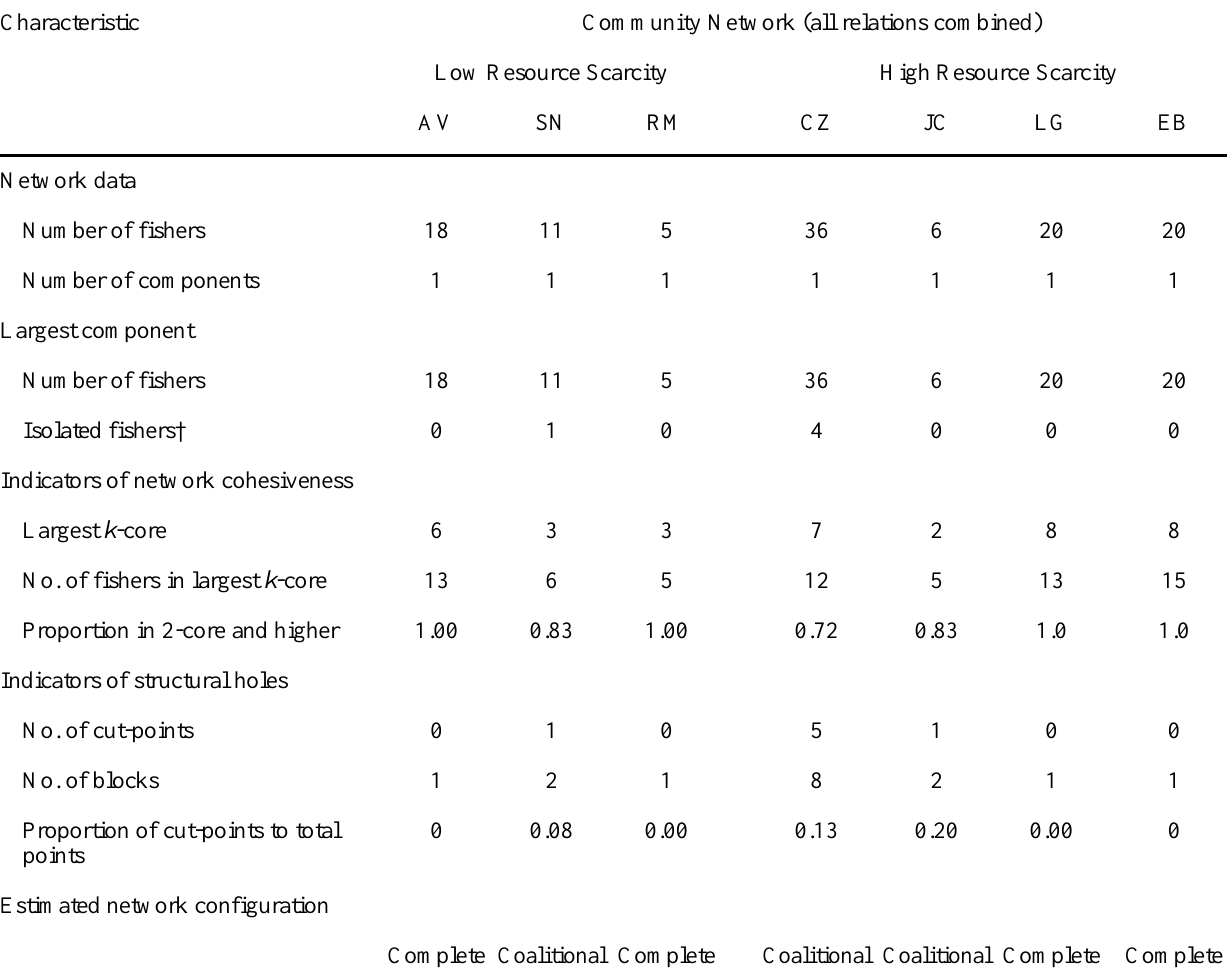
Characteristic Community Network (all relations